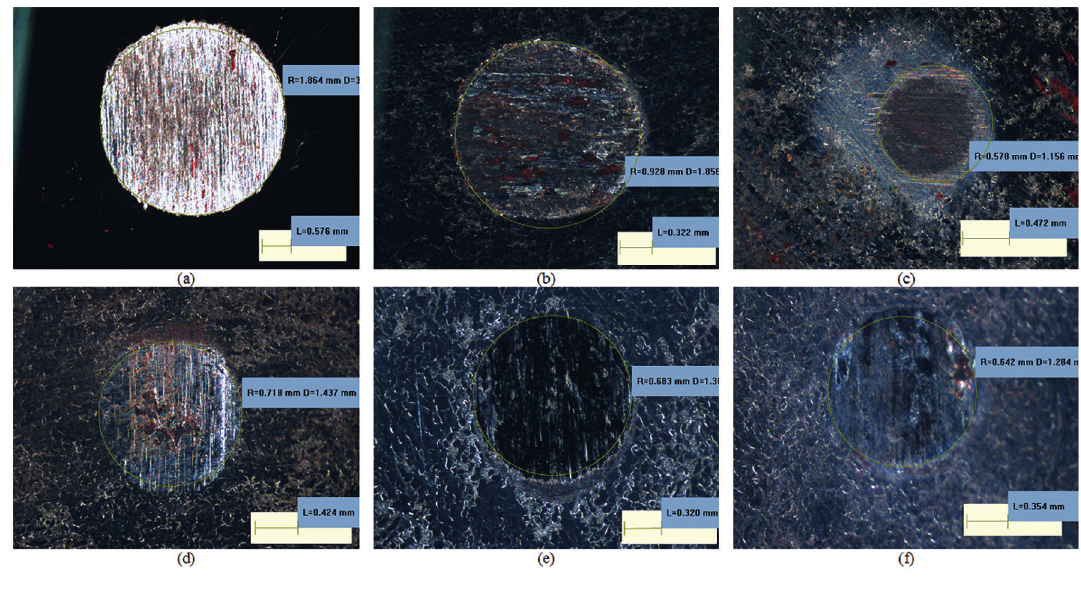
Figure 8: Caps produced in wear tests of nitrided materials under a maximum load of 16 N at (A) 350 ºC, (B) 400 ºC, (C) 450 ºC, (D) 500 ºC, (E) 550 ºC and (F) 570°C.